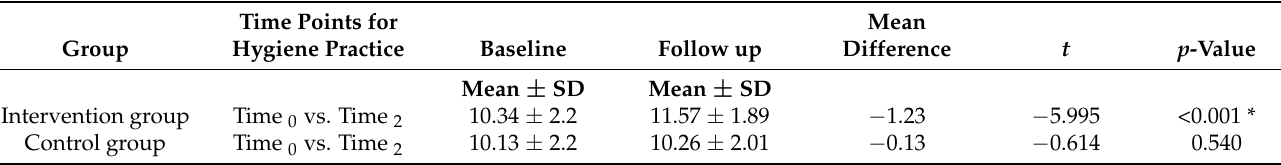
Table 4. Mean scores of WASH practice from baseline to follow up (3 months after intervention) within intervention and control